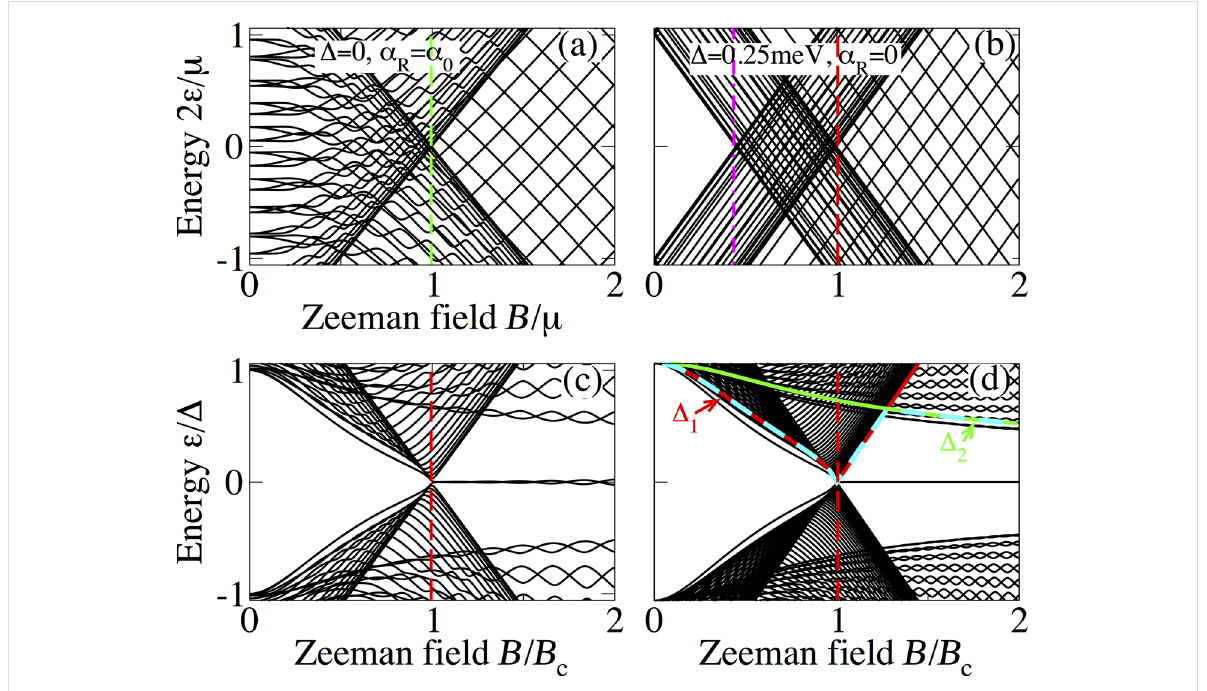
Figure 2: Low-energy spectrum of a superconducting nanowire as function of the Zeeman field B . At zero superconducting pairing with finite SOC the spectrum is gapless and becomes spin-polarized at B = μ as indicated by the green dashed line (a), while a finite superconducting pairing with zero SOC induces a gap for low values of B (b). As B increases, the induced gap is reduced and closed at B = Δ (vertical magenta dash-dot line). The bottom panels correspond to both finite superconducting pairing and SOC for L S = 4000 nm (c) and L S = 10000 nm (d). Note that as the Zeeman field increases the spectrum exhibits the closing of the gap at B = B c . While in the trivial phase, B < B c , there are no levels within the induced gap (c,d), in the topological phase for B > B c , the two lowest levels develop an oscillatory behaviour around zero energy (c). These lowest levels are the sought-for MBSs. For sufficiently long wires the amplitude of the oscillations is reduced (d) and these levels acquire zero energy. Solid red, green and dashed cyan curves indicate the induced gaps Δ 1,2 and min( Δ 1 , Δ 2 ). Parameters: α 0 = 20 meV·nm, μ = 0.5 meV, Δ = 0.25 meV and L S = 4000 nm